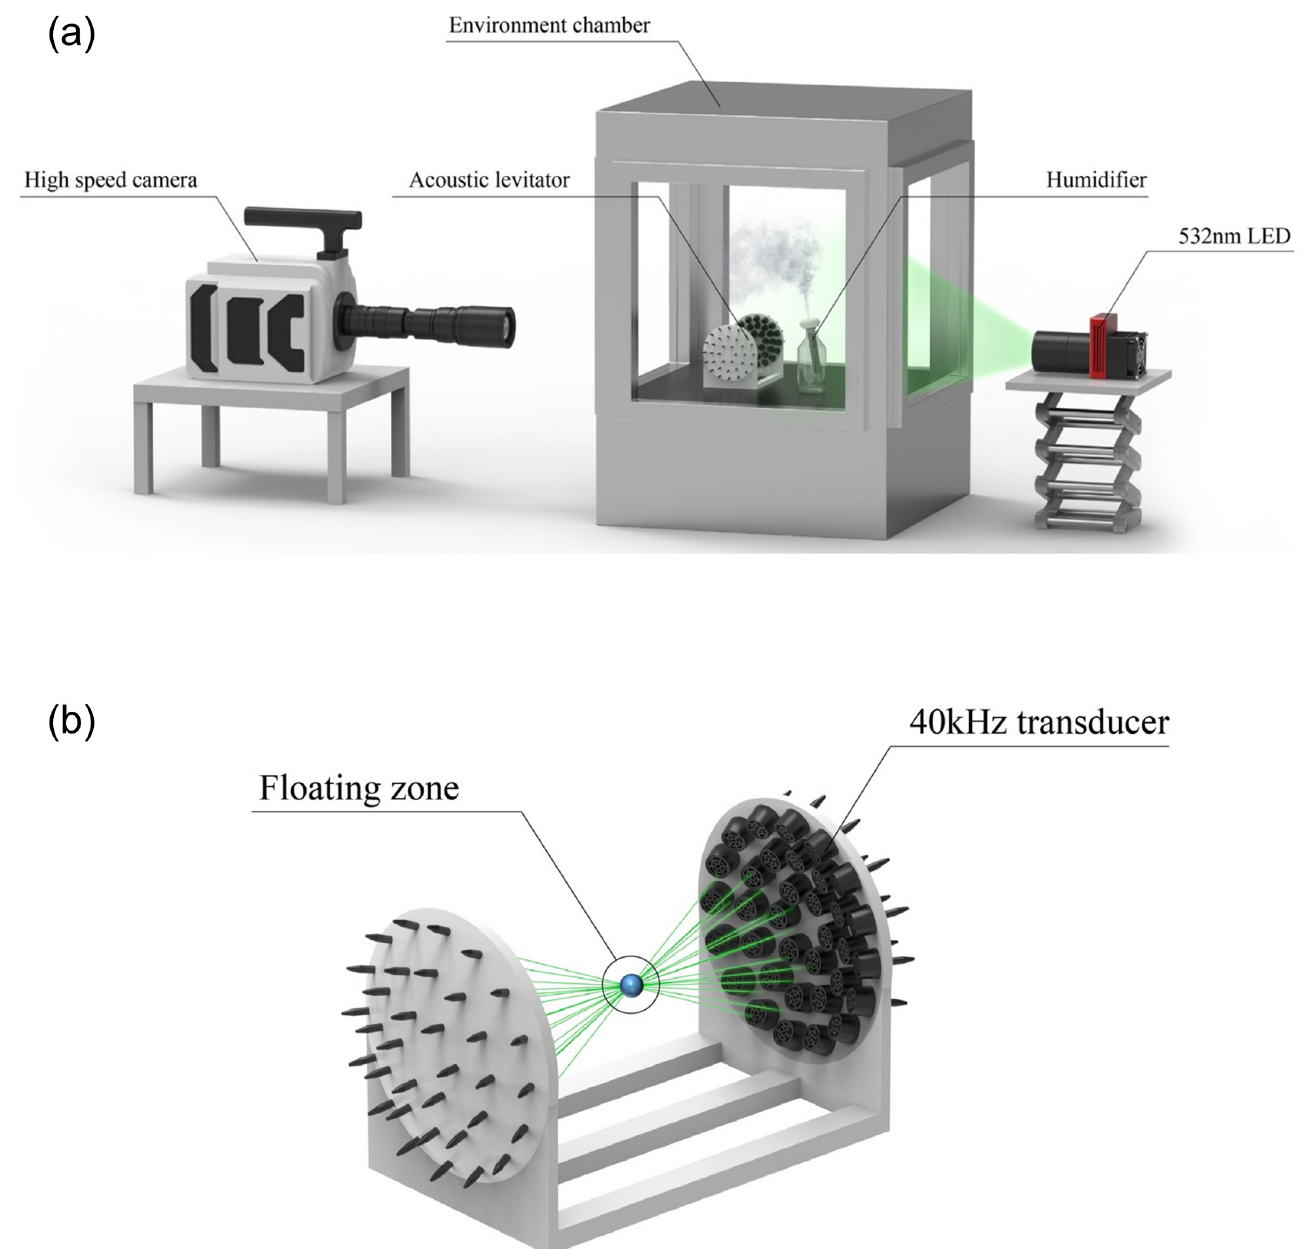
Fig 1. Schematic of experimental setup. (a) Droplet evaporation experimental setup, (b) schematic of acoustic levitator.